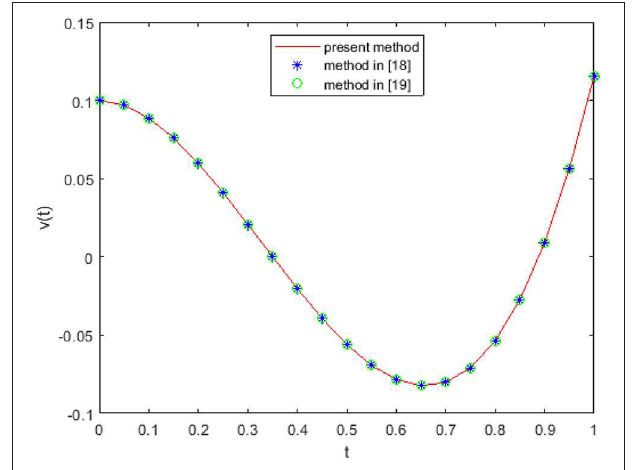
f 1 and β 2. = = = 2 and n 3 for case 2. = = Present